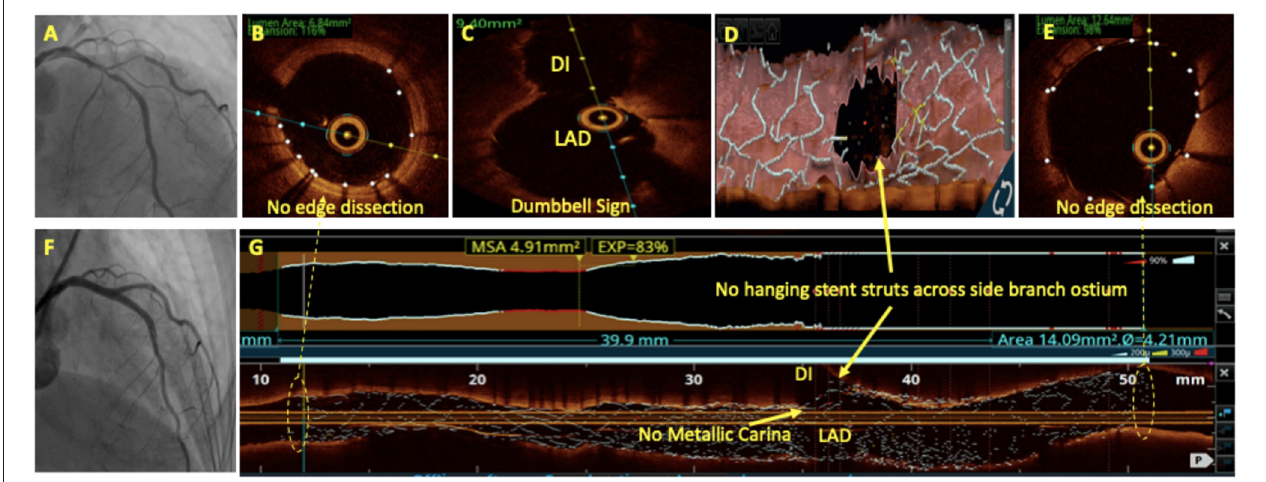
FIGURE 8 | OCT in bifurcation angioplasty. Coronary angiography showed a significant LAD/D1 stenosis (A) with Medina class (1, 1, 1). Patient underwent bifurcation angioplasty with two stents using the DK crush technique (F) . OCT run of LAD after final KBI showed no edge dissection (B,E) and dumbbell sign (C) . No hanging stent struts seen across D1 ostium on 3D reconstruction (D) and on L mode (G) . No neo-metallic carina seen at LAD/D1 bifurcation on the rendered stent view (G) .